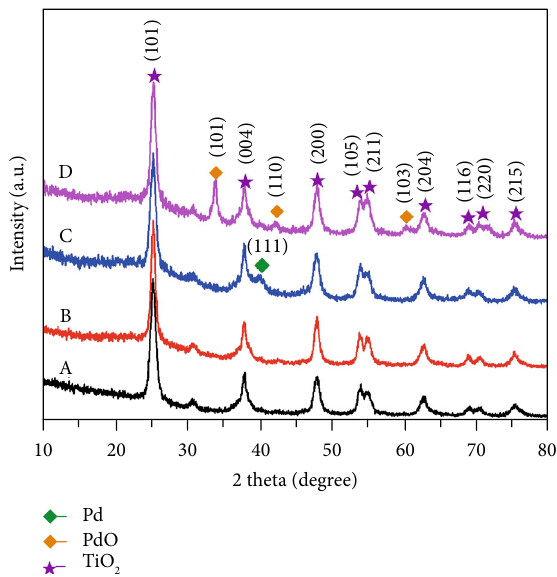
Figure 1: Typical XRD patterns of (a)TiO and (d)TiO